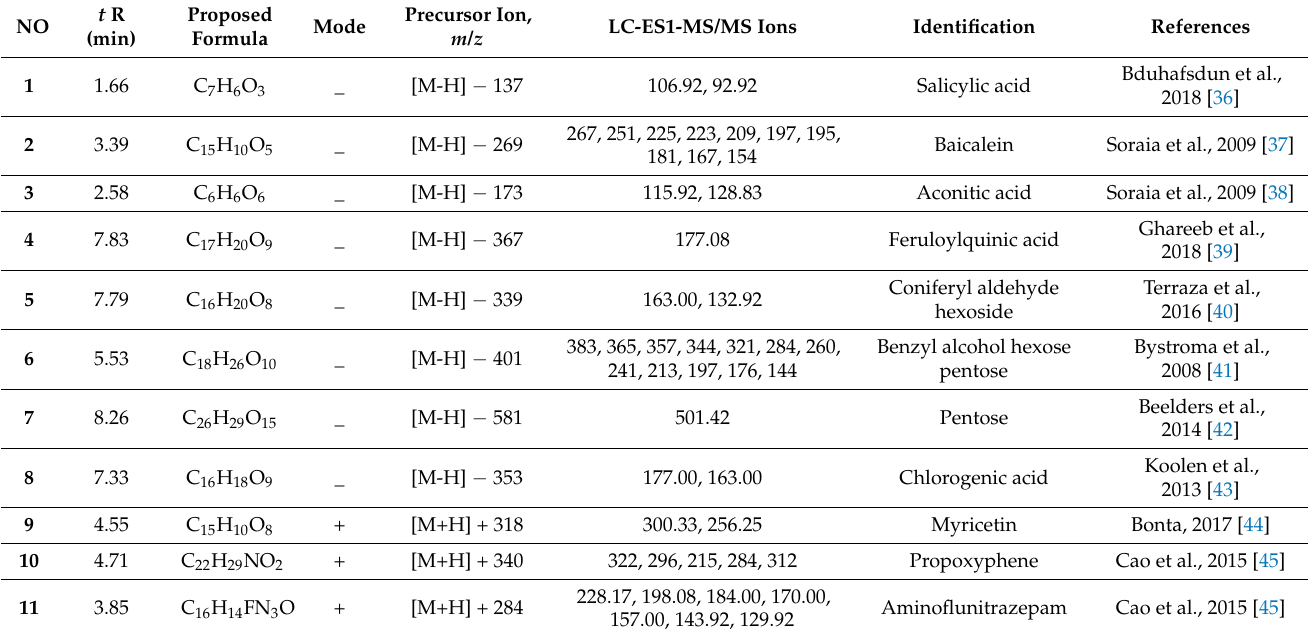
Table 2. Characterization of chemical constituents in the extract of C. membranifaciens FH15 by LC-ES1-MS/MS